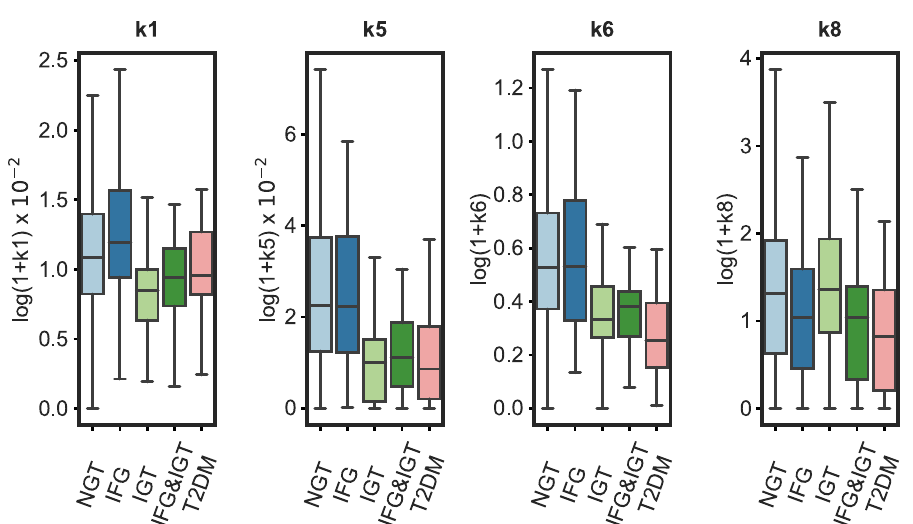
Fig 5. The distribution of the estimated parameters k 1, k 5, k 6, k 8 by subgroup based on ADA diabetes criteria. k 1—rate constant of glucose appearance in the gut, k 5—rate constant of insulin-dependent glucose uptake, k 6—rate constant of insulin secretion proportional to glucose elevation, k 8—rate constant of insulin secretion by the rate of change in glucose elevation. For details, see S1 Appendix. Observations outside the interquartile range of the 25 th and 75 th percentile of each group are visualized in S5 Fig. The boxes represent the 25th and 75th percentiles, the whiskers represent the min, and max values, and the horizontal line represents the